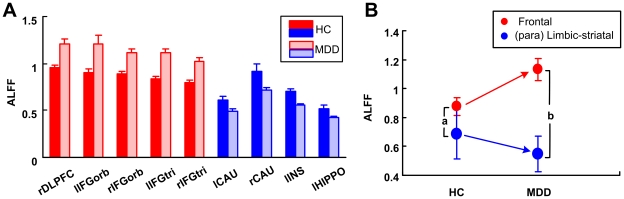
Brain ctivity imbalance in the fronto-subcortical activities shown by ALFF during resting-state.
A: The mean ALFF of each ROI defined on Figure 1 for the HC and MDD groups was obtained by averaging across the HC subjects (n = 18; solid bar) and MDD patients (n = 18; dashed bar) in the frontal regions (red) and (para) limbic-striatal regions (blue). Error bars denoted the standard deviation of the mean ALFF across the subjects. B: The imbalance of fronto-(para) limbic striatal activities at a system level. The mean ALFF values of the ROIs in the frontal and the (para) limbic-striatal systems were further averaged to obtain the ALFF of the two systems (red: frontal, blue: (para) limbic-striatal). Error bars denote standard deviation of the mean ALFF across ROIs. The difference between the ALFF of the two systems in the HC and MDD group were shown by the letter of ‘a’ and ‘b’ respectively, whose numerical value are 0.189 and 0.585. This figure also demonstrated inter-group comparisons. From the HC to MDD, the frontal ALFF exhibits an increased trend (red arrow), whereas the (para) limbic-striatal ALFF exhibited a decreased trend (blue arrow).